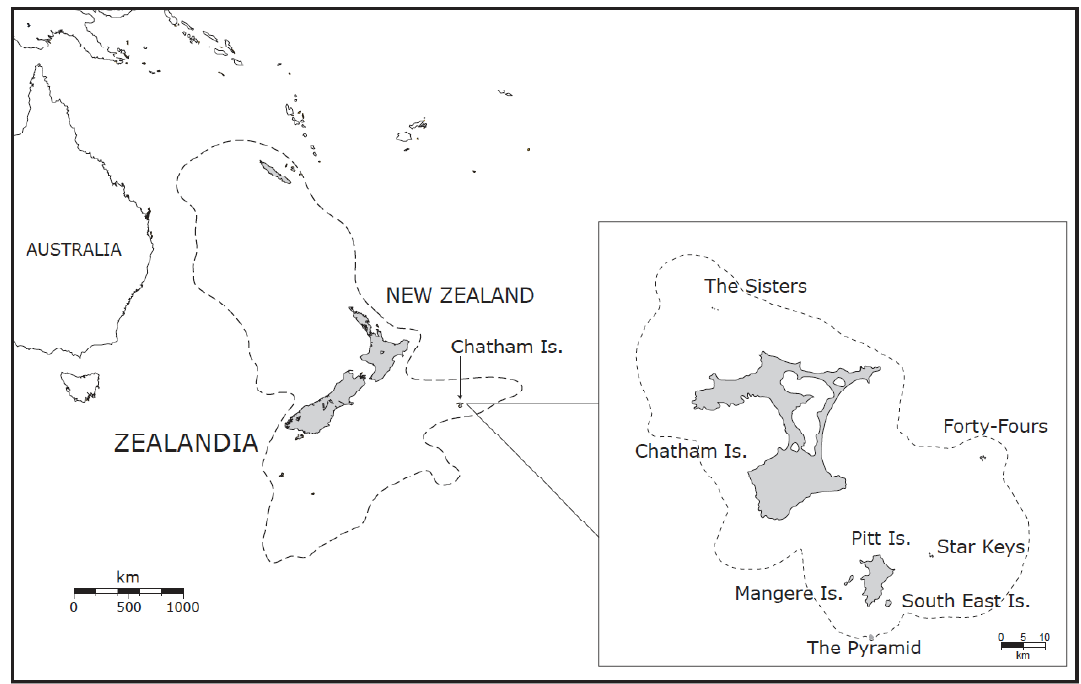
Figure 1. The New Zealand region, showing New Zealand (grey) and the outline of Zealandia (broken line). Inset shows the Chatham Islands (grey) and probable subaerial region during the last glacial maximum